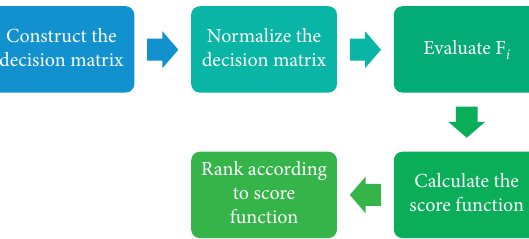
Figure 1: Flow chart of Algorithm